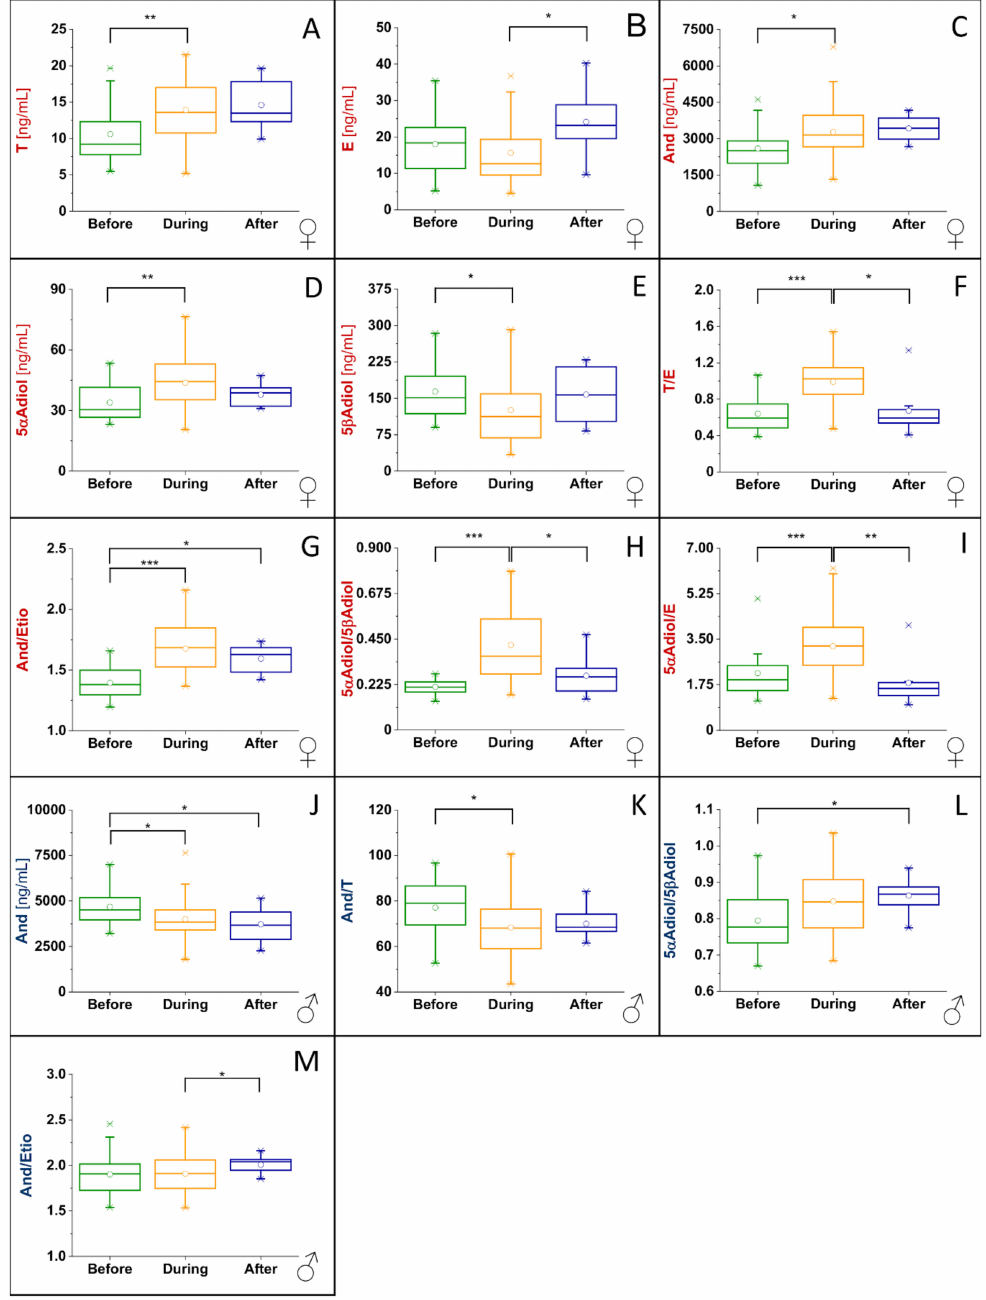
Figure 5. Boxplots of steroid profile markers with significant di ff erences between at least two groups. ( A – I ): female volunteer; ( J – M ): male volunteer; * significant di ff erence with p < 0.0167; ** very significant di ff erence with p < 0.0033; *** highly significant di ff erence with p <